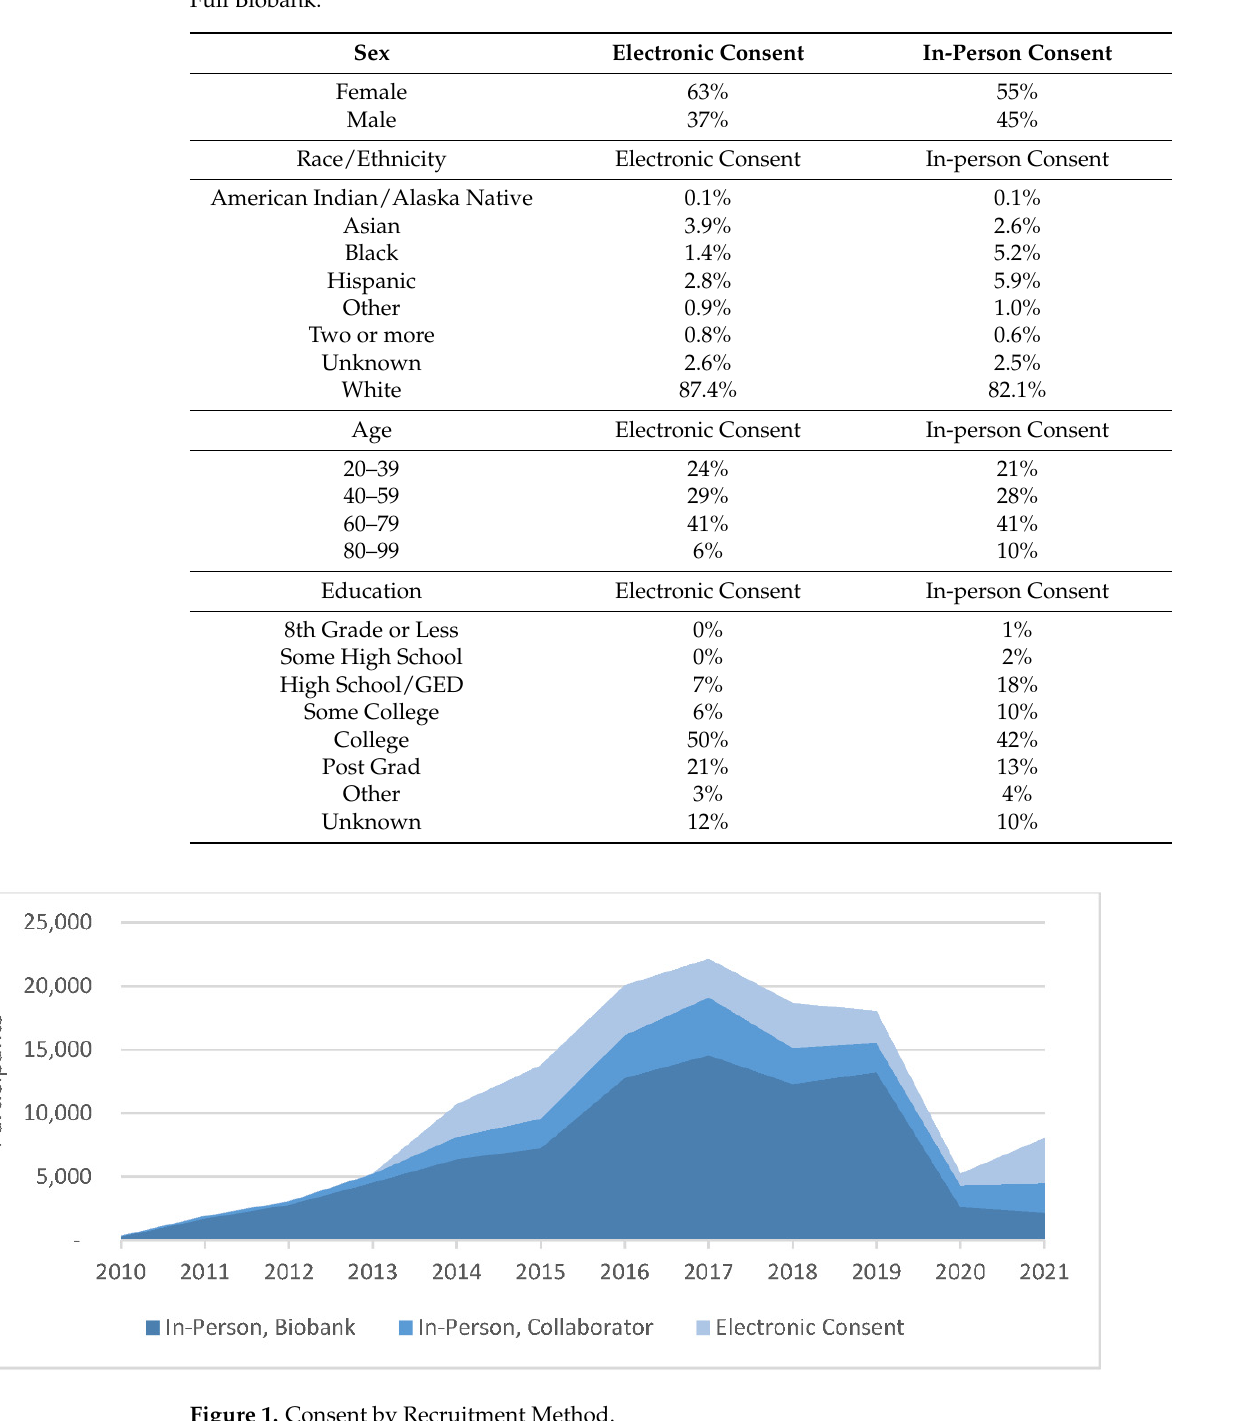
Table 1. Demographics of Electronic Informed Consent Compared to Demographics of the Full Biobank.